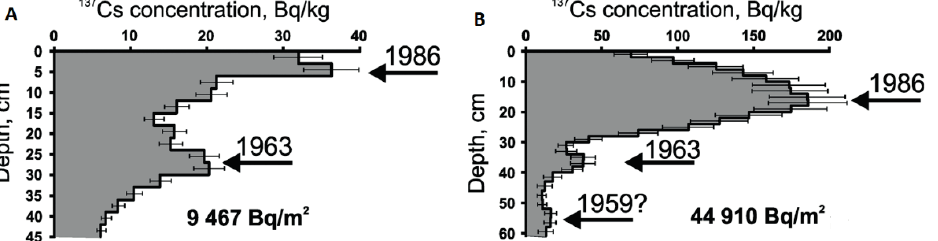
Fig. 2 137 Cs profiles associated with sediment cores collected from the floodplains of the Zusha River (A) and the Turdei River (B) in Russia. (based on Golosov et al .,